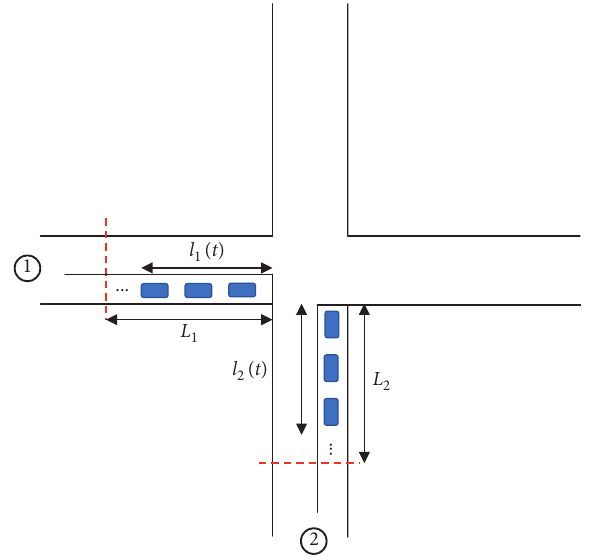
Figure 3: An intersection layout considering queue length